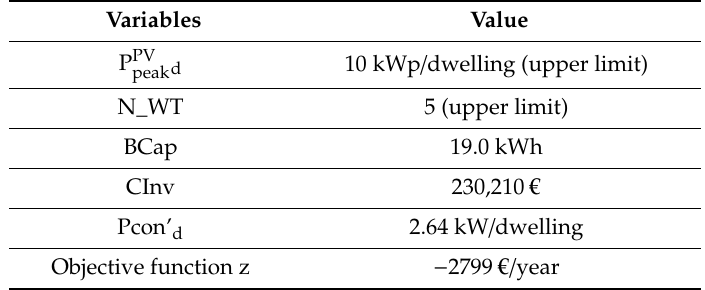
Figure 4. Solar production (green) and individual consumption (orange) for the most probable Table 13. Results of the on-grid model: First-stage variables and objective function. scenario during one week of April. Source: self-elaboration.